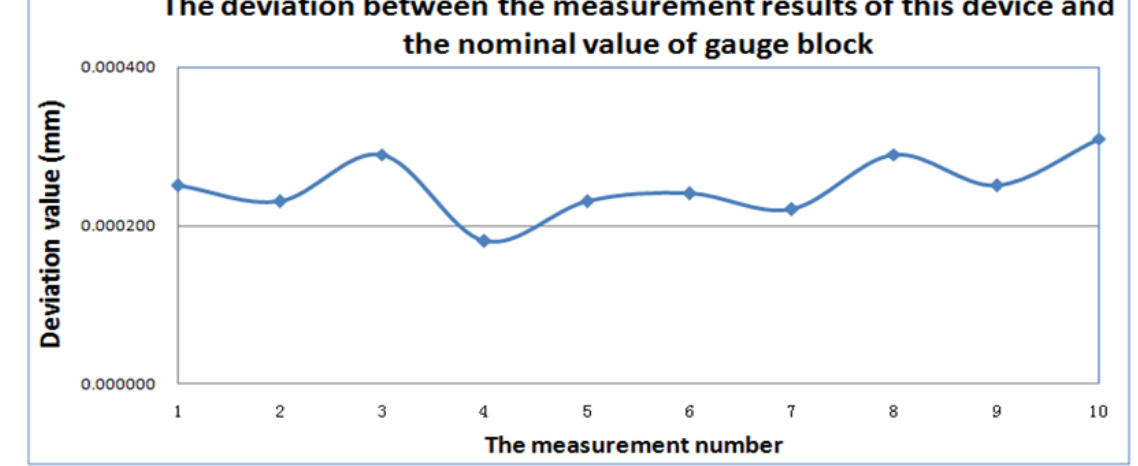
Figure 7. The trend chart of deviation of measurement result of this device from nominal value.